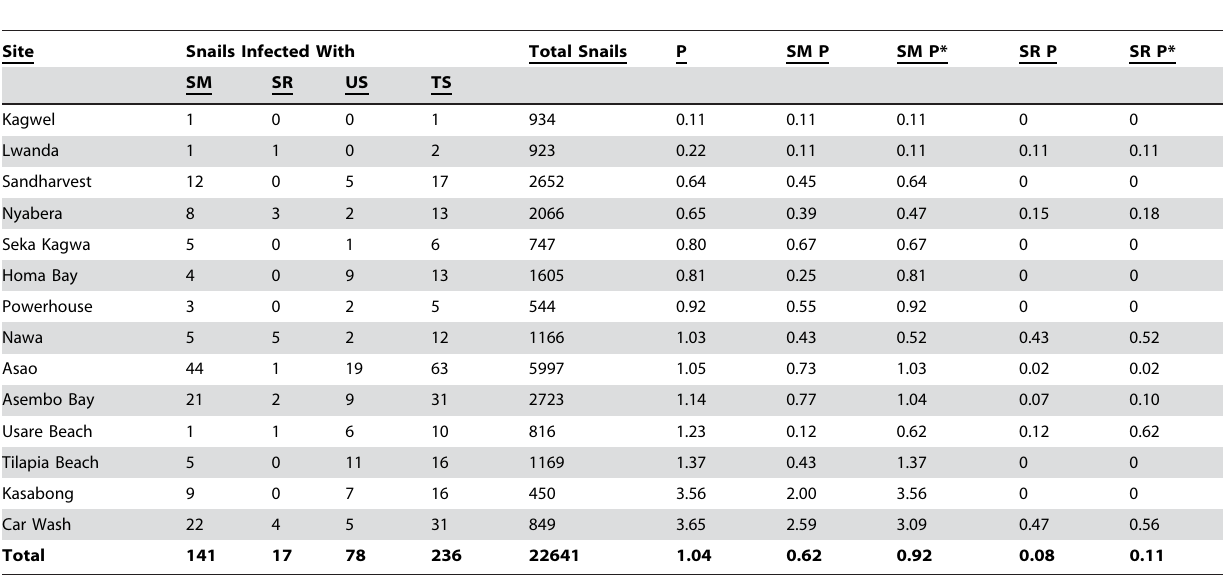
Table 2. The number of snails infected with Schistosoma mansoni (SM), Schistosoma rodhaini (SR), unidentified mammalian schistosomes (US), and total schistosomes (TS) at various sites in the Lake Victoria Basin of Kenya.